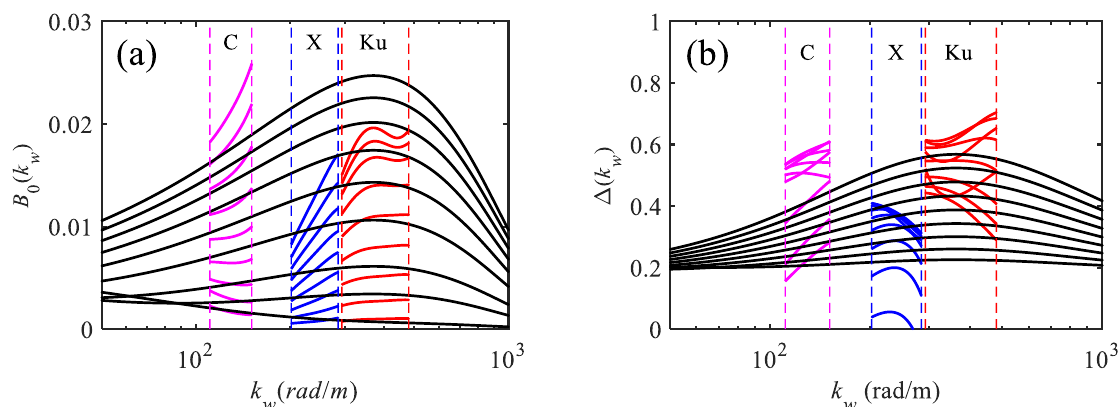
Figure 2. The inverted “pure” Bragg wave spectrum is compared with the E spectrum as wind speed ranges from 3 m/s to 21m/s with a 2 m/s step. ( a ) The omni-directional part of the curvature spectrum, and ( b ) the term ∆ ( k w ) in spreading function. The purple, blue, and red curves correspond to the region of C-, X-, and Ku-bands.